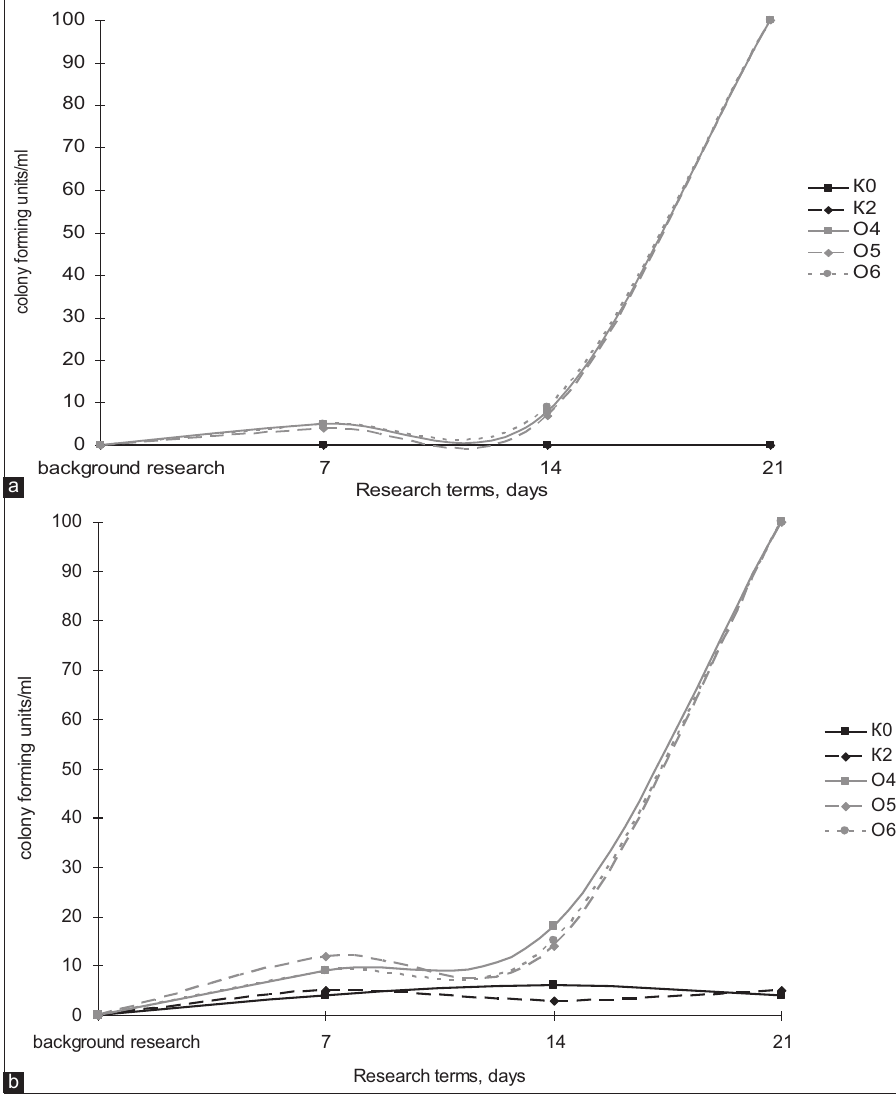
– “Vetom-2” and copper, О 4